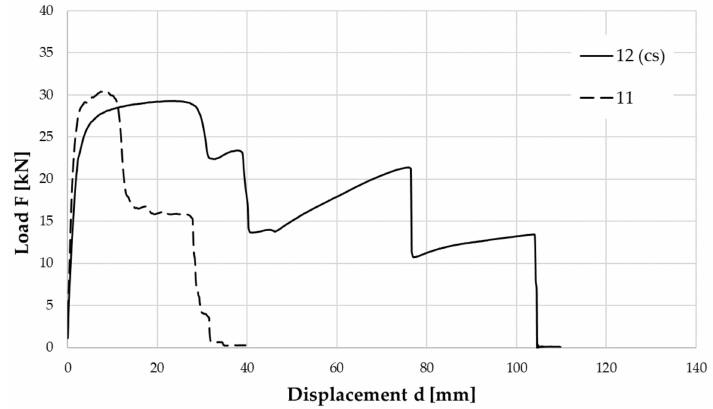
Figure 24. Tensile load-displacement response curves of samples 11 and 12, with elastomer layers made by non-dissipative and dissipative compounds,